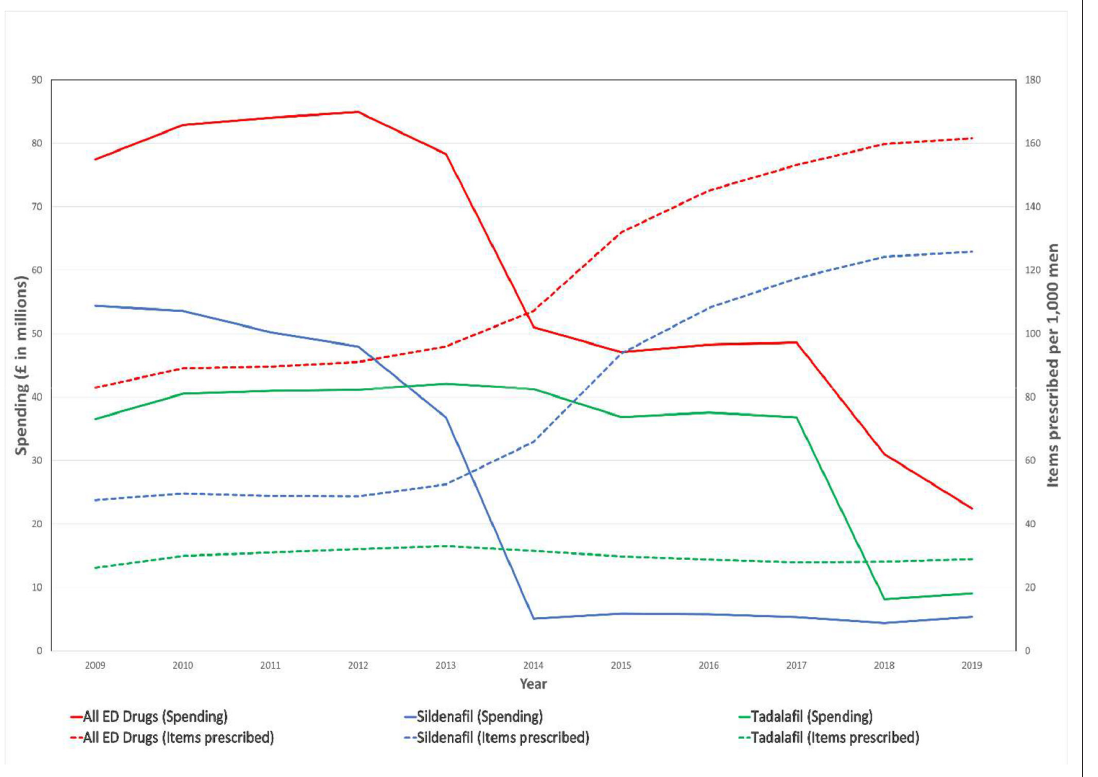
Figure 1 Volume and costs of prescribing for ED medicines from 2009–2019 in English primary care. ED = erectile